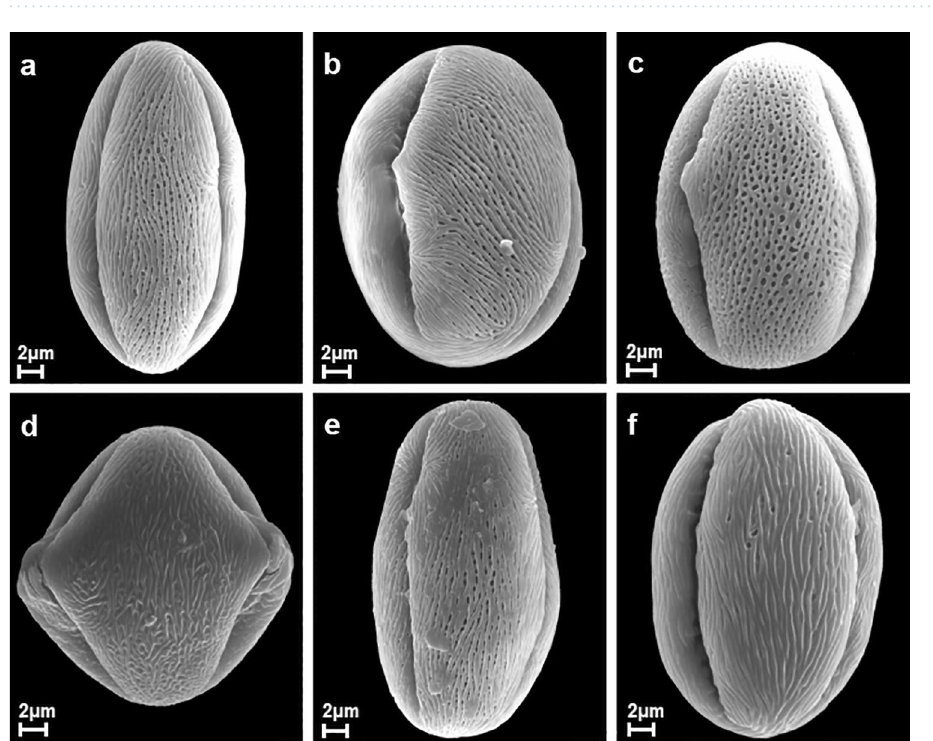
Figure 2. Pollen grains of P. serotina in equatorial view after application of various herbicides (( a ) – Chikara, ( b ) – Chwastox, ( c ) – Logo, ( d ) – Mustang, ( e ) – Roundup, ( f ) –